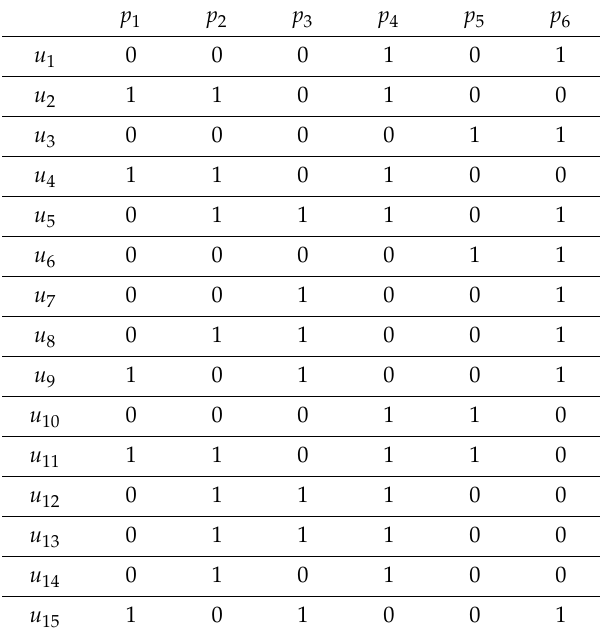
Table 3. Original matrix UPA original .